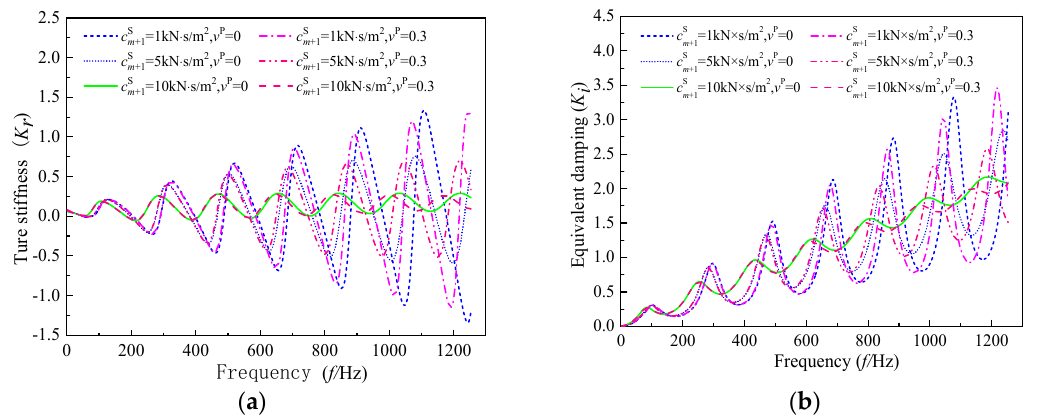
stiffness; ( b ) equivalent damping. ( b ) equivalent damping. Appl. Sci. 2020 , 10 , x FOR PEER REVIEW